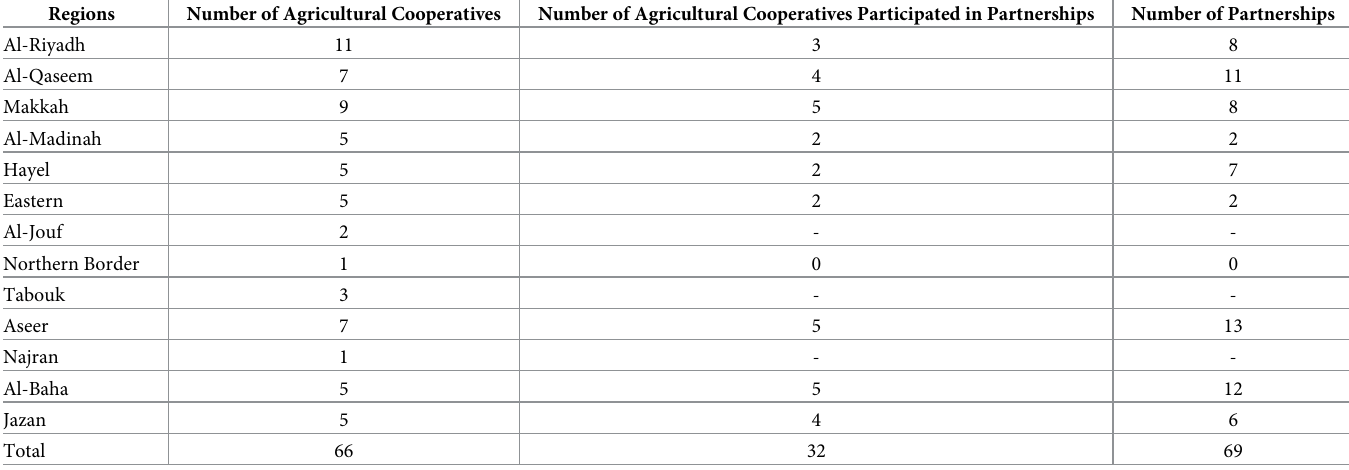
The (-) sign shows that no response has been received from some agricultural